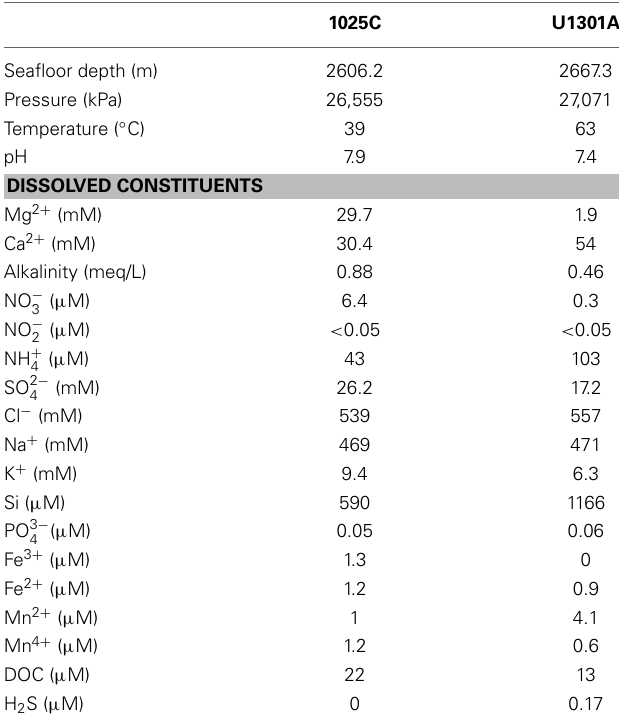
Table 1 | Chemical composition of basement fluids collected from boreholes 1025C and